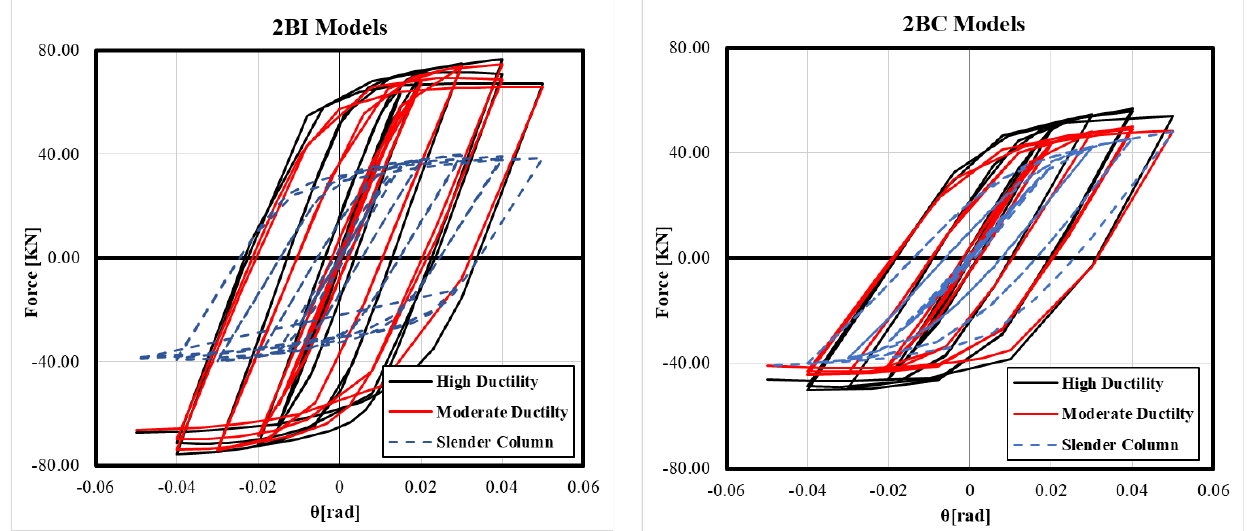
Figure 14. Hysteretic curves for all models analyzed.